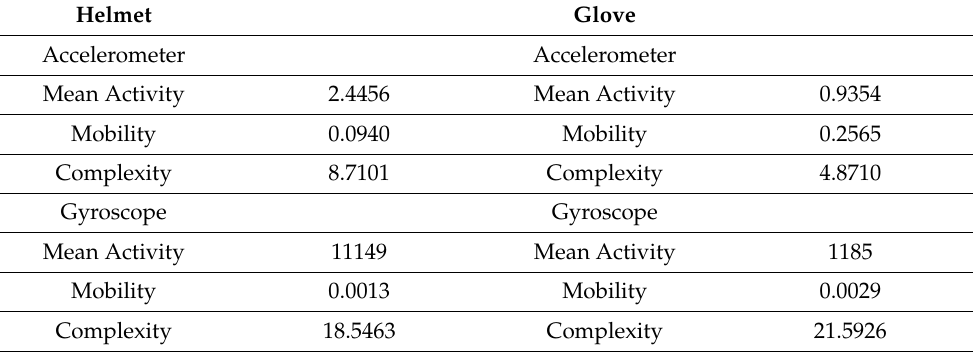
Table 4. Hjorth parameters.